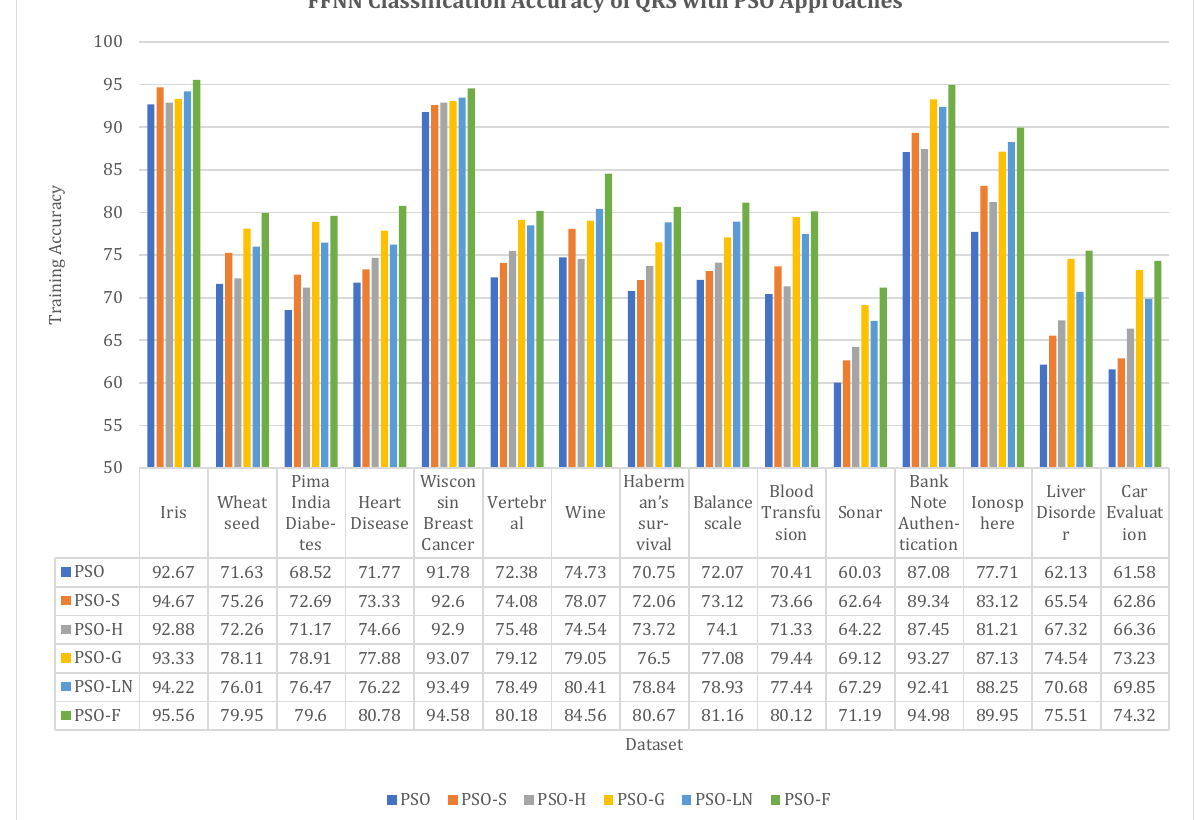
Figure 9. Testing accuracy result of QRS with PSO.